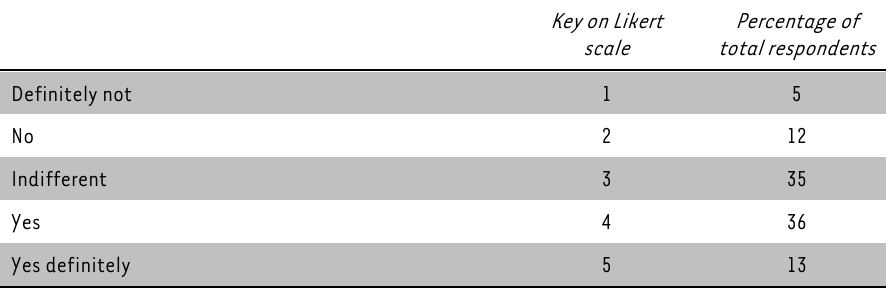
Key on Likert Percentage of scale total respondents